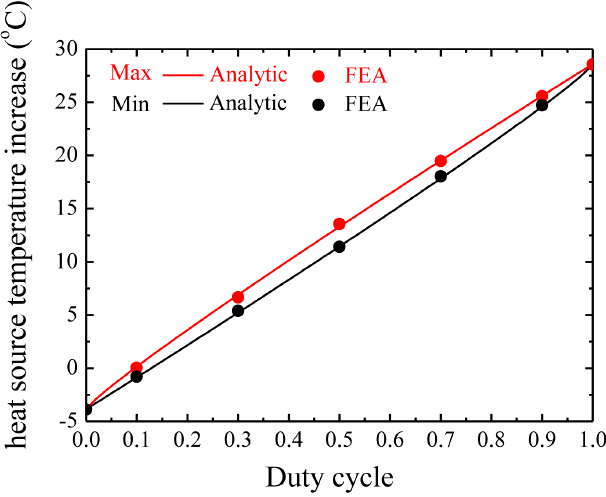
Figure 4. The maximum and minimum heat source temperature increase after saturation versus duty cycle.